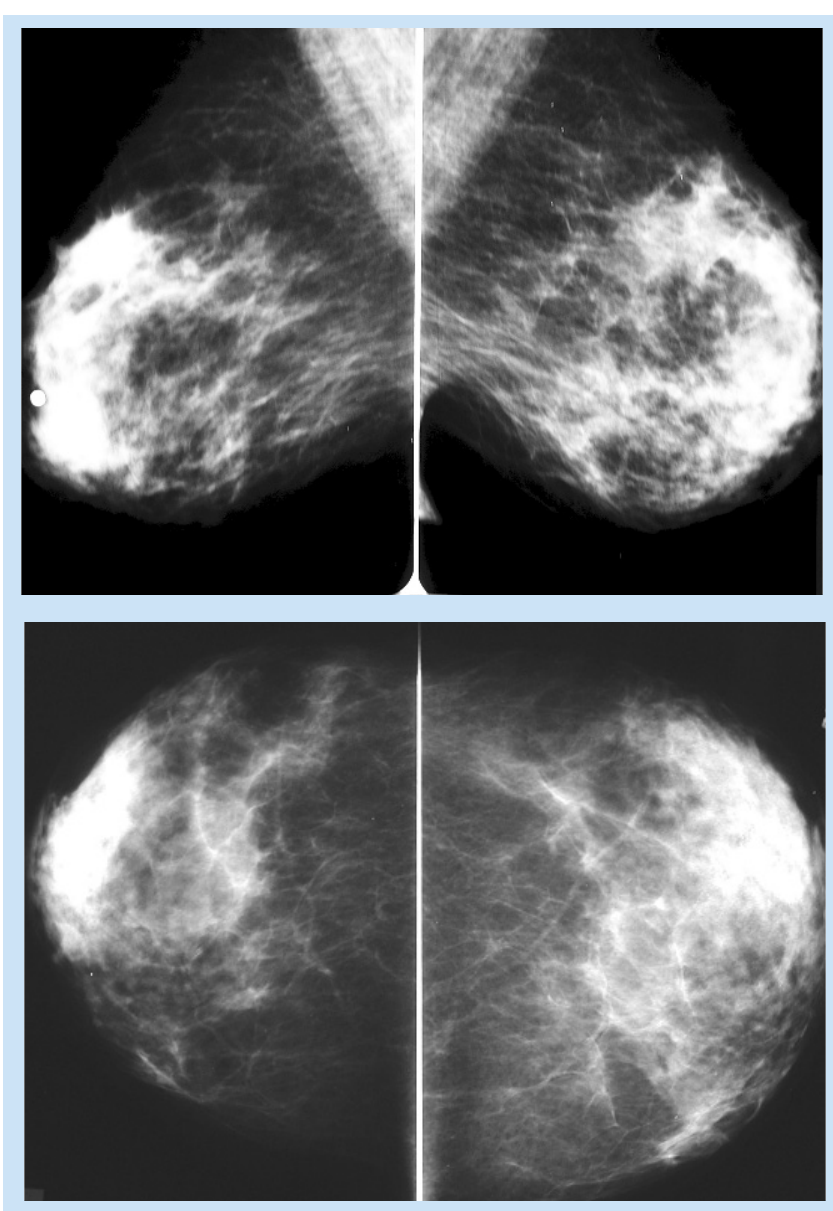
Fig.1a,b. Mediolateral and craniocaudal mammograms of case 1 demonstrate nonspecific increased density in the upper outer quadrant of the left